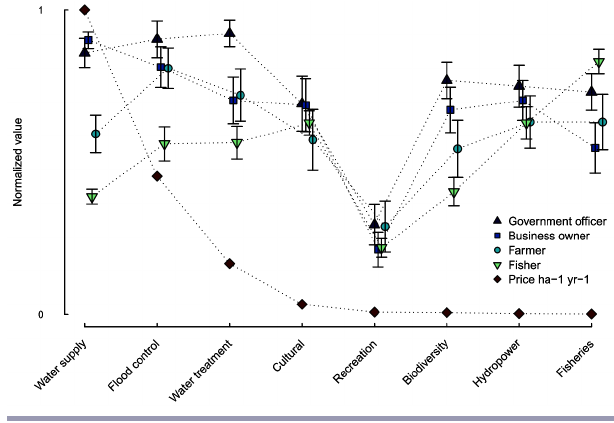
Fig. 3 . Normalized scores and standard error of ecosystem services of mean stakeholder perception values from Shaoguan, China, and normalized mean monetary valuation. Lines have been added to help visualize the differences in rank of the services within each site, compared to the monetary